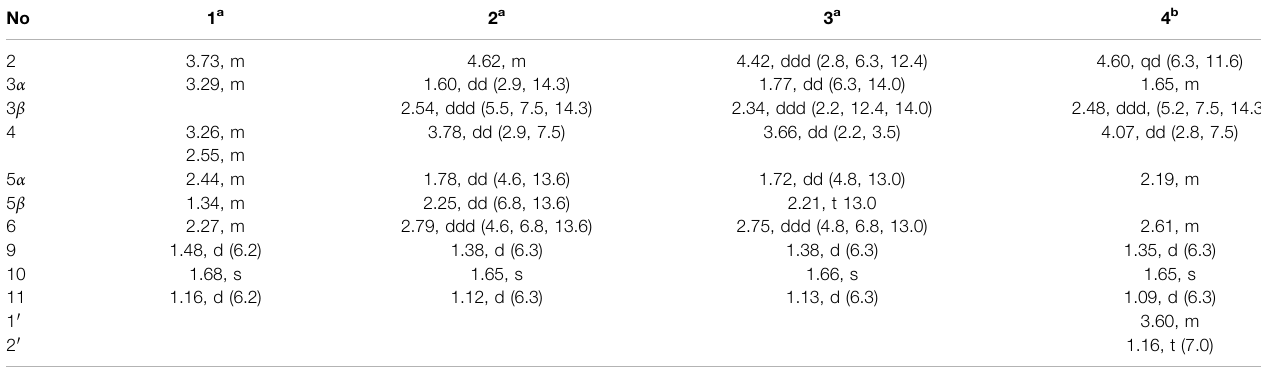
TABLE 1 | 1 H (500 MHz) NMR data for compounds 1 – 4 ( δ in ppm, J in